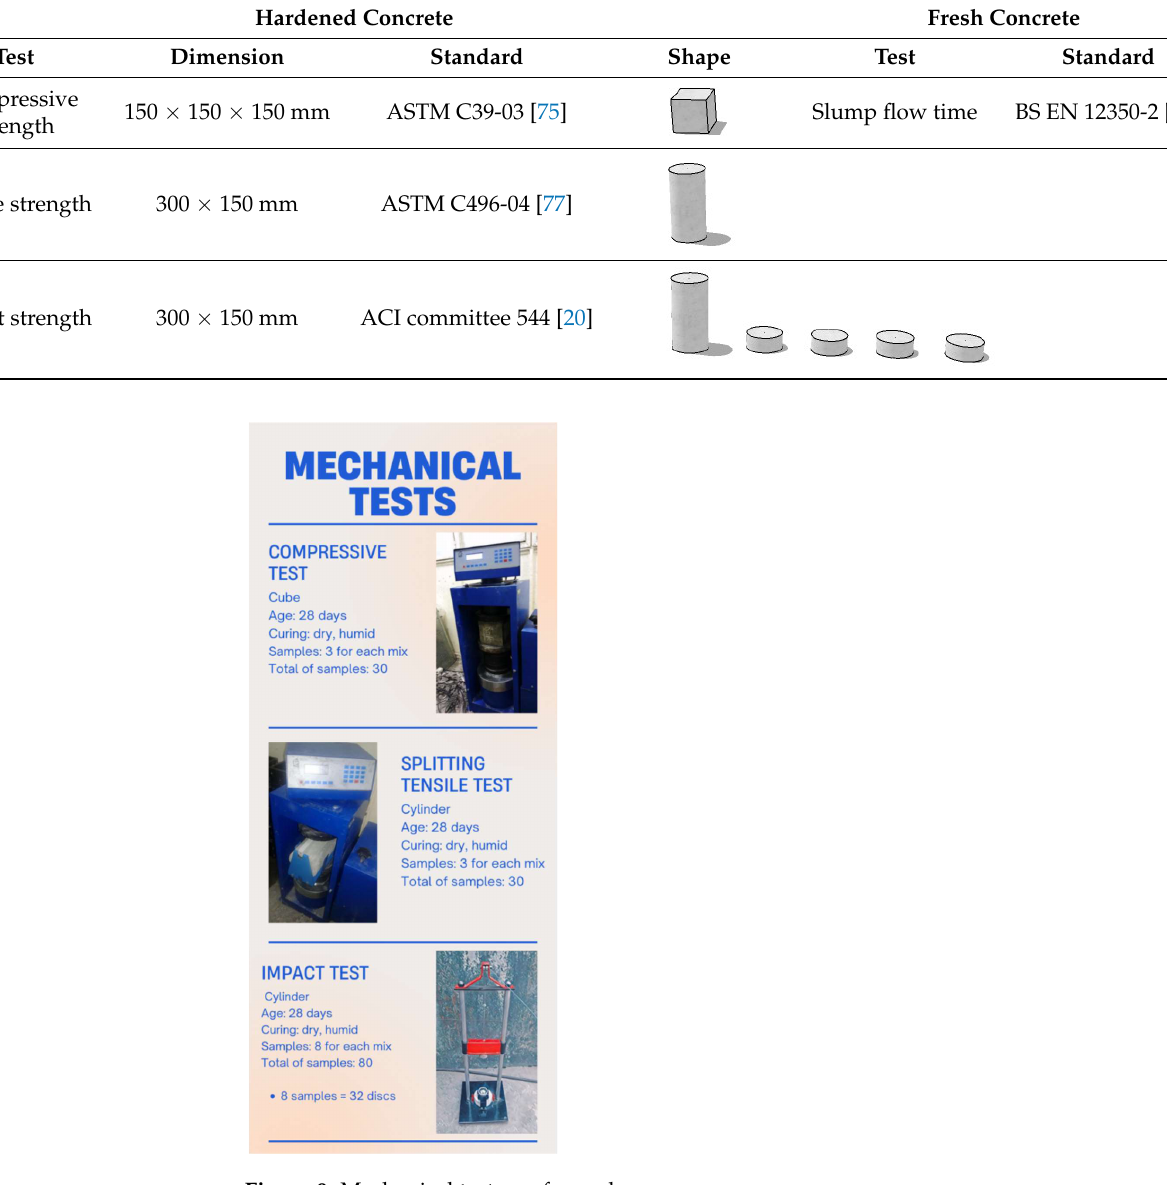
Table 6. Characteristics of tests, specimens, and standards.